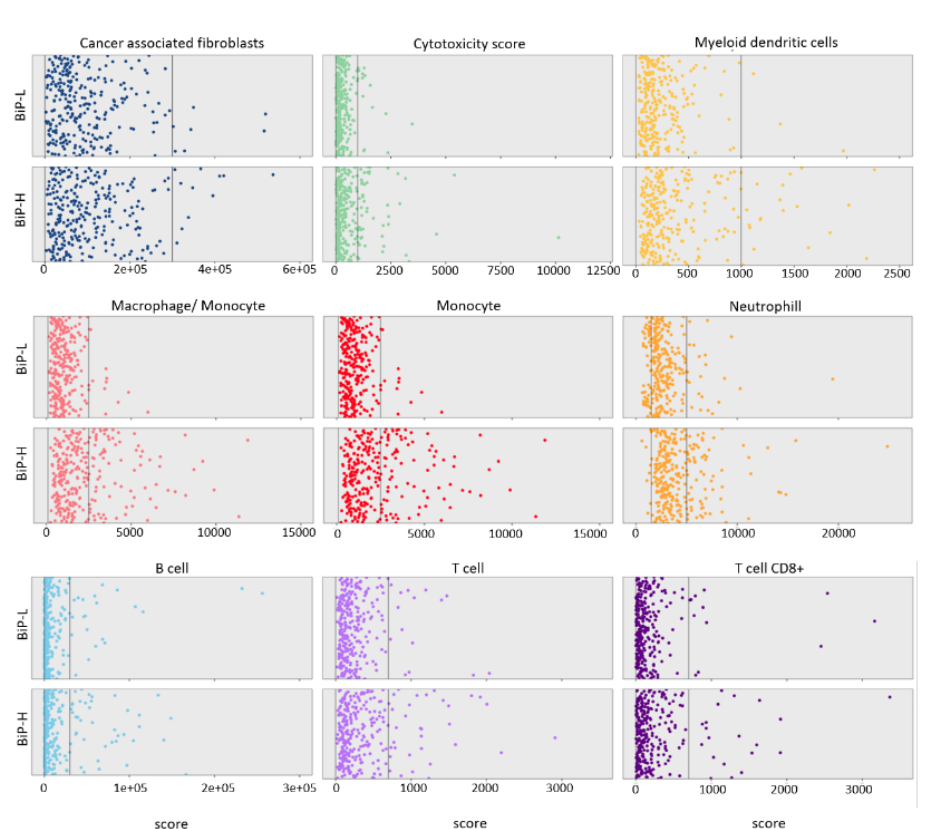
Figure 2. Association of BiP differential expression (high vs. low; BiP-H and BiP-L, respectively) with tissue-infiltrating immune and stromal cell populations using the mcp_count method from the immunodeconv package and TCGA-BRCA data overall.